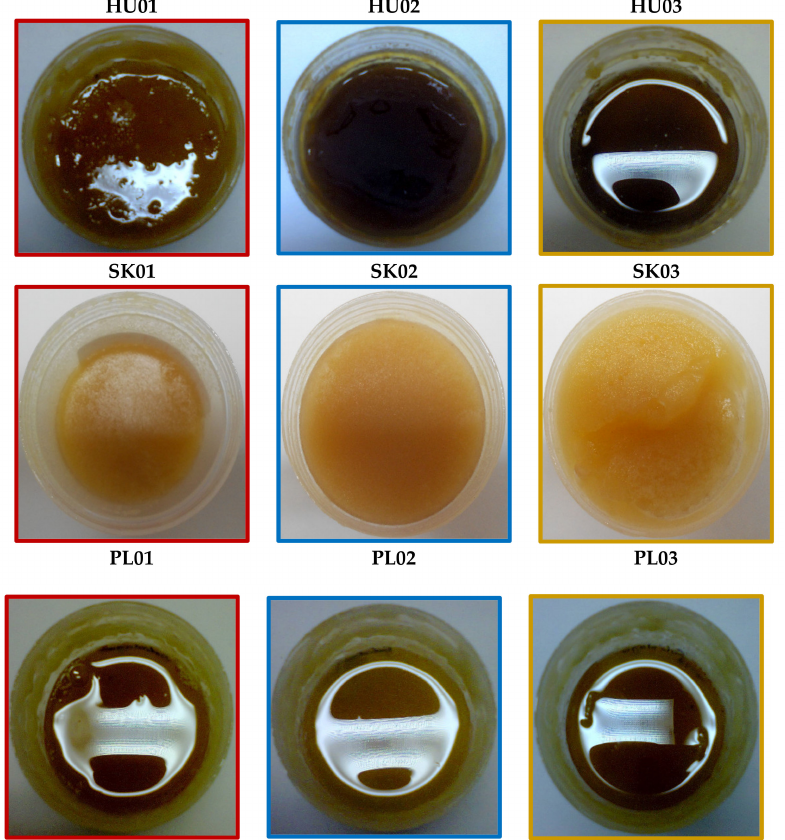
Figure 3. Hungarian- (HU01–HU03), Slovak- (SK01–SK 03), and Polish-origin (PL01–PL03) golden- rod